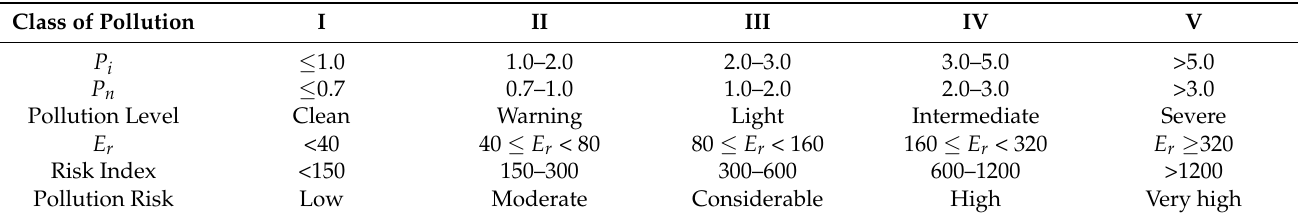
Table 1. Grading standards for pollution indices